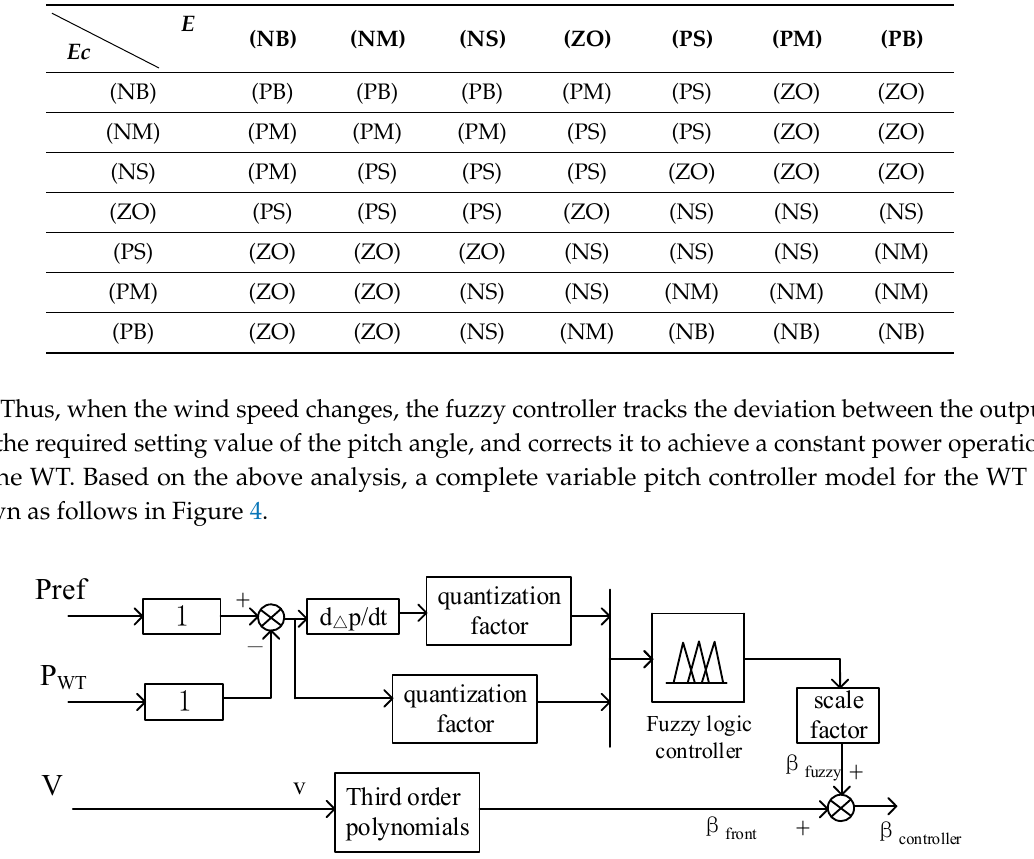
Table 1. Fuzzy rule table for the controller.